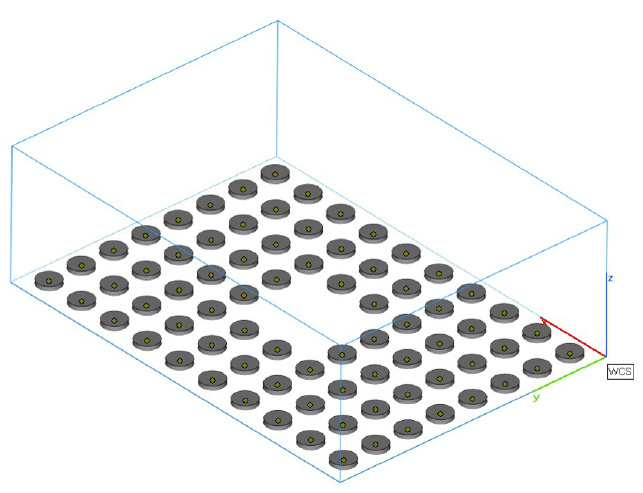
Figure 10. Print job layout for measuring the warpage characteristics across the build platform.